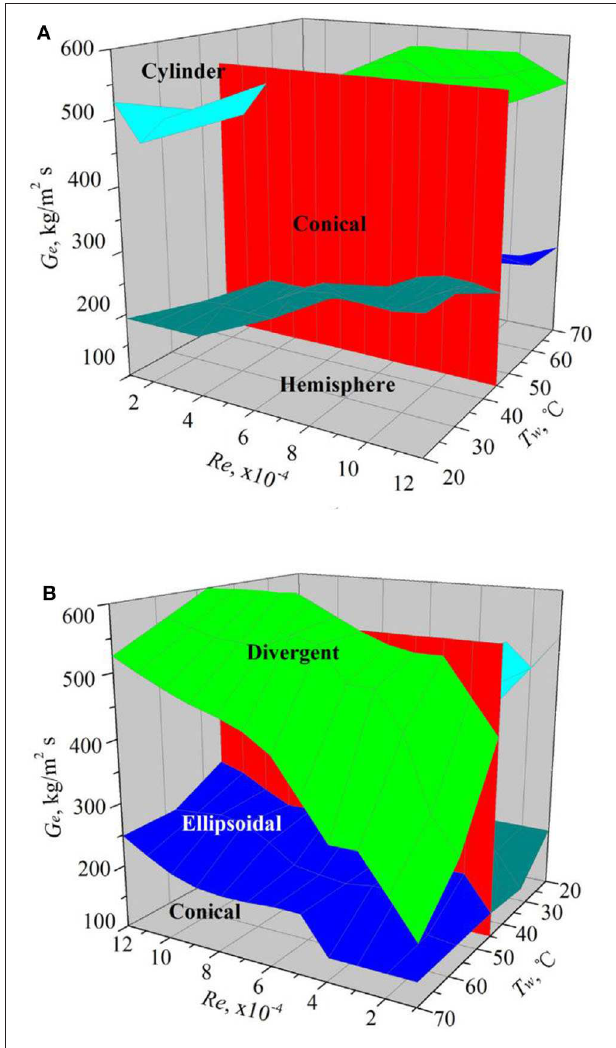
FIGURE 8 | The regime map developed by Xu et al. (2013). (A) View from a side with low water temperature. (B) View from a side with high water